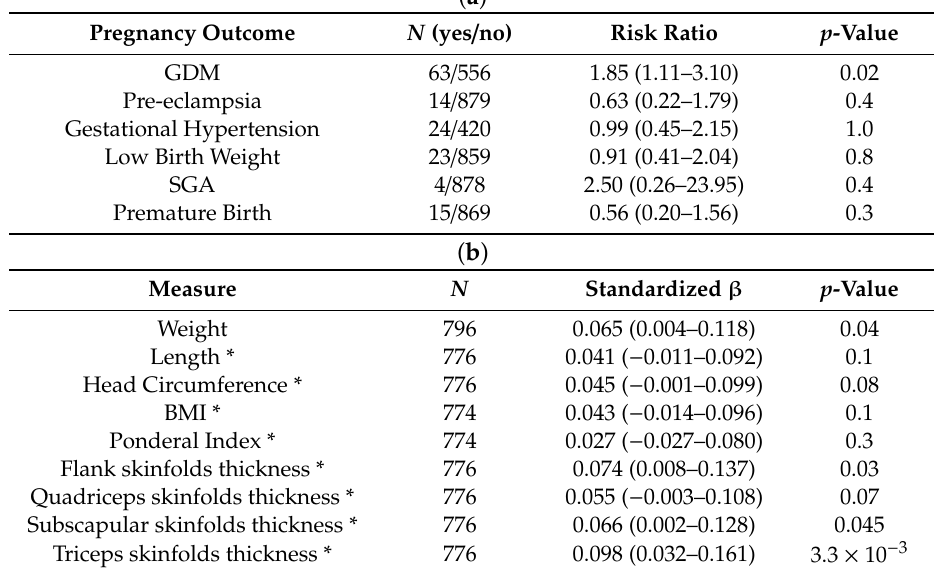
Table 4. Associations of micronutrient supplementation in pregnancy with ( a ) outcomes of pregnancy and ( b ) o ff spring size at birth and adiposity in women and babies without